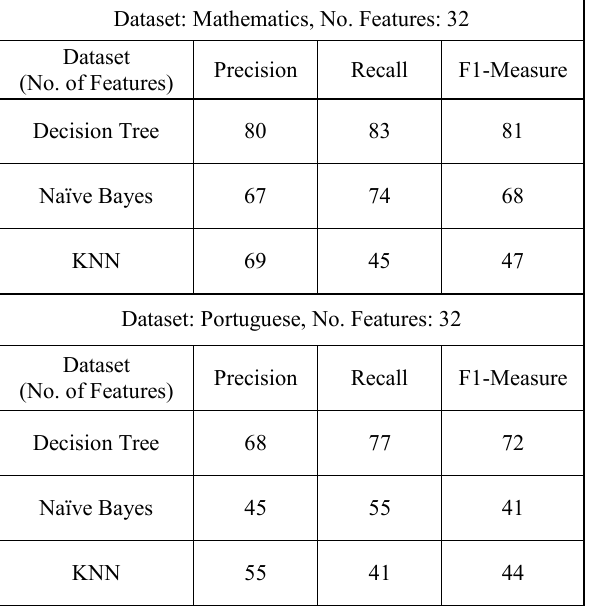
Table 3. Prediction accuracy with feature selection (hybrid method).